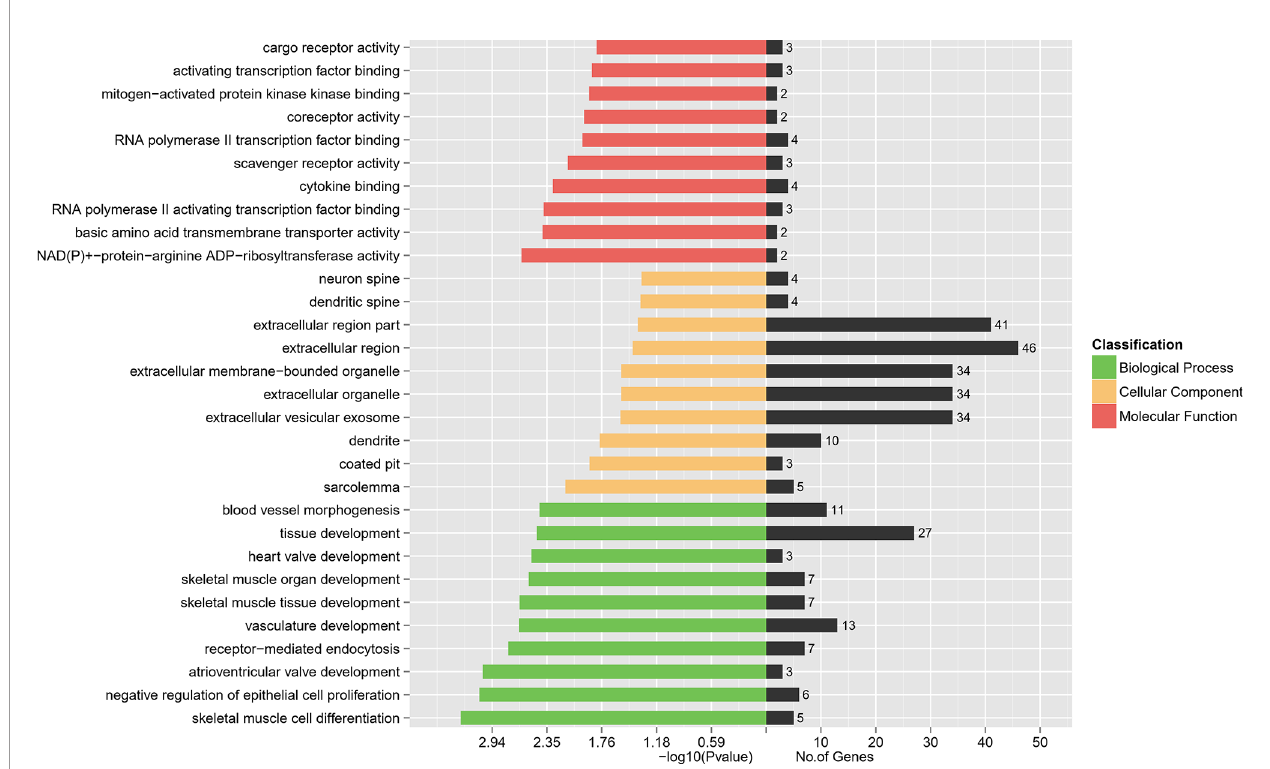
FIGURE 3 | DEGs ’ GO enrichment classi fi cation. The red bars represent the Molecular Function. The yellow bars represent the Cellular Component while the green represent the Biological Process.